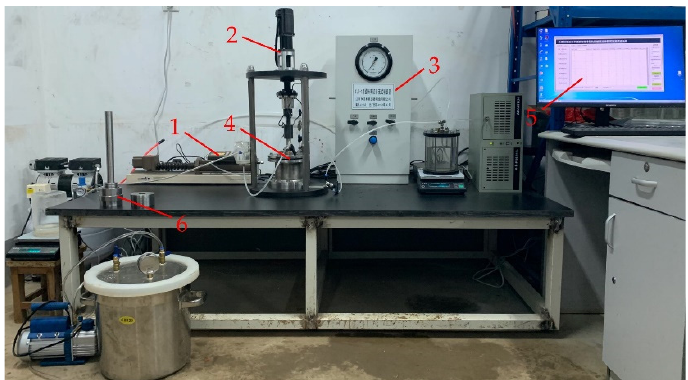
Figure 2. Image of the shear-seepage test system: 1 confining pressure system, 2 rotary shear system, 3 seepage pressure system, 4 shear-seepage pressure chamber, 5 automatic data acquisition system, 6 specimen preparation system.